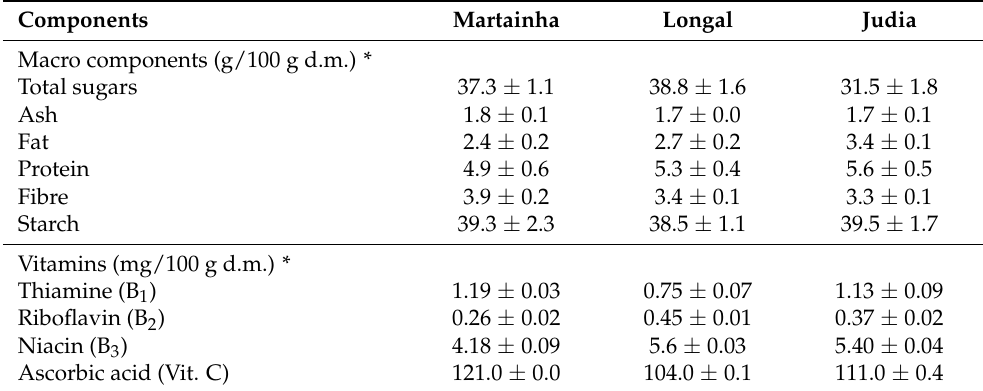
Figure 1. Chestnut cultivars native from Portugal used in the study [14]. Table 1. Nutritional characterization of the regional cultivars of chestnut [14]. Components Martainha Longal